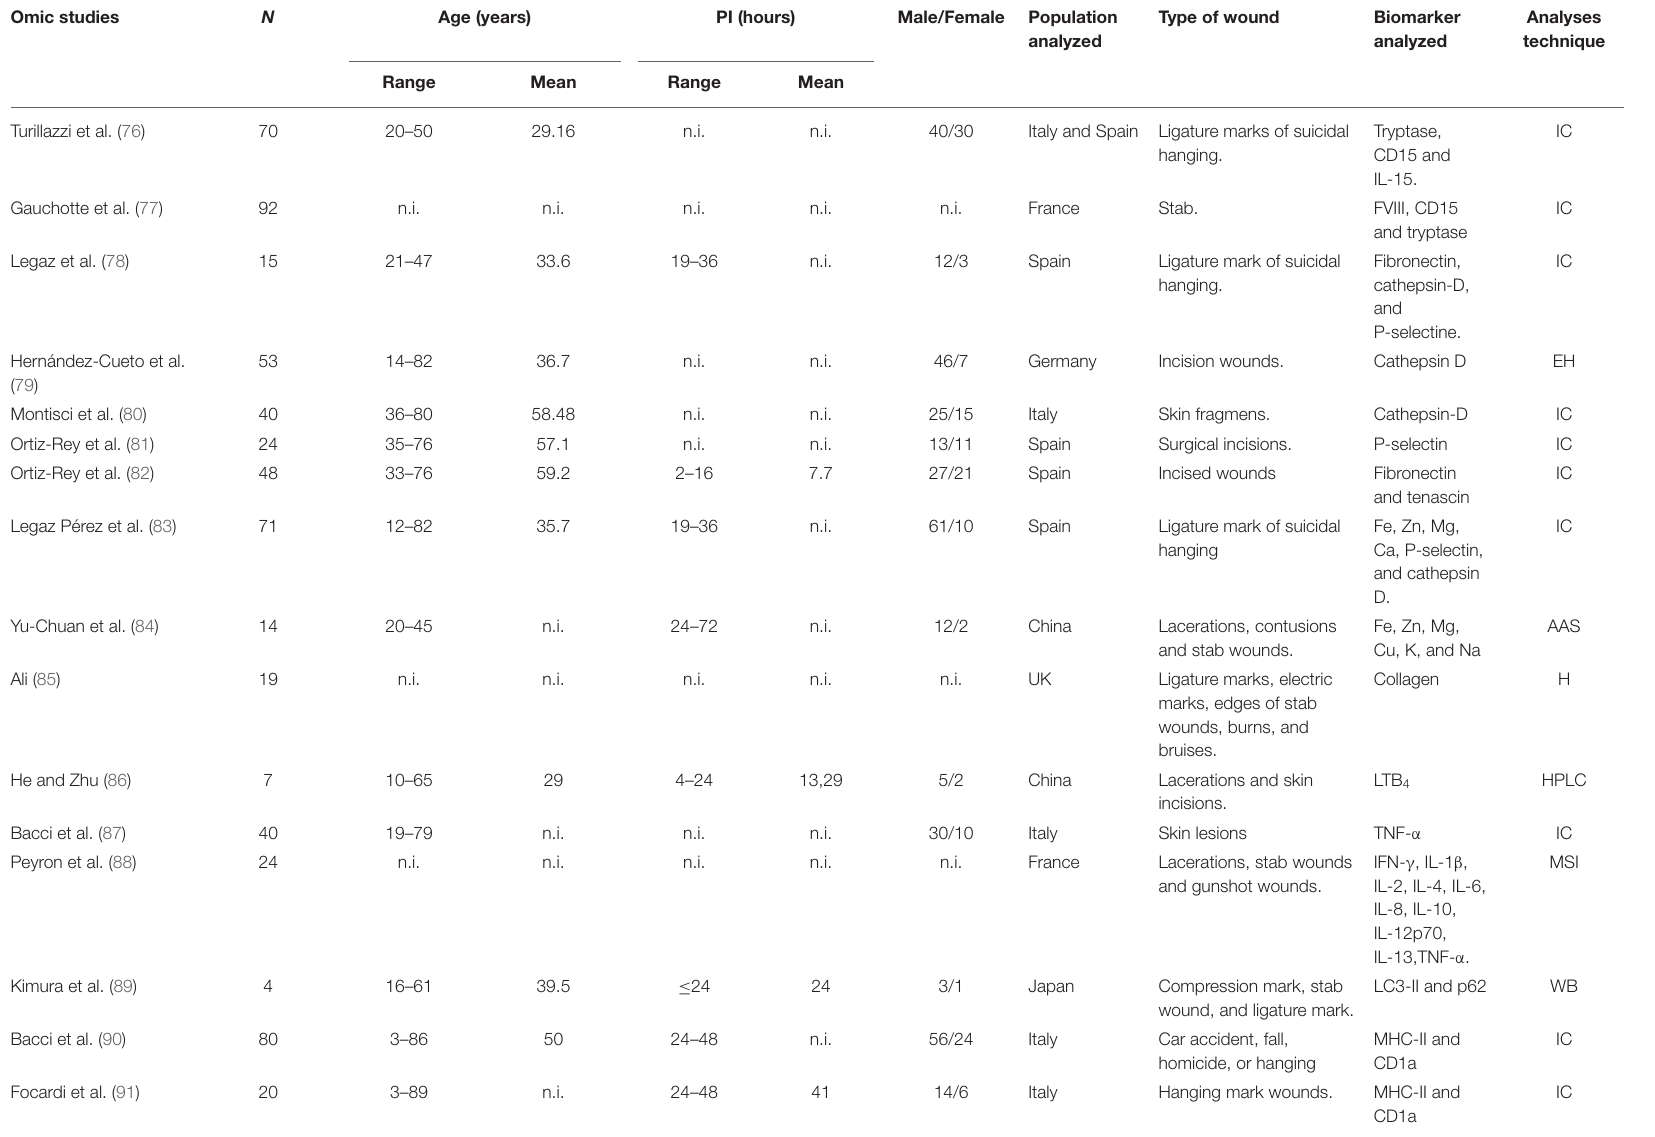
a n, number of individuals or samples. PI, post-mortem interval; n.i., not indicated; q-DNA analysis, quantitative DNA analysis; IC analysis, Immunohistochemical Analysis; EH analysis, Enzyme histochemical analysis; WB, western blot; AAS, Atomic absorption spectrometry; H analysis, Histological analysis; HPLC, liquid chromatography; MSI, Multiplex sandwich